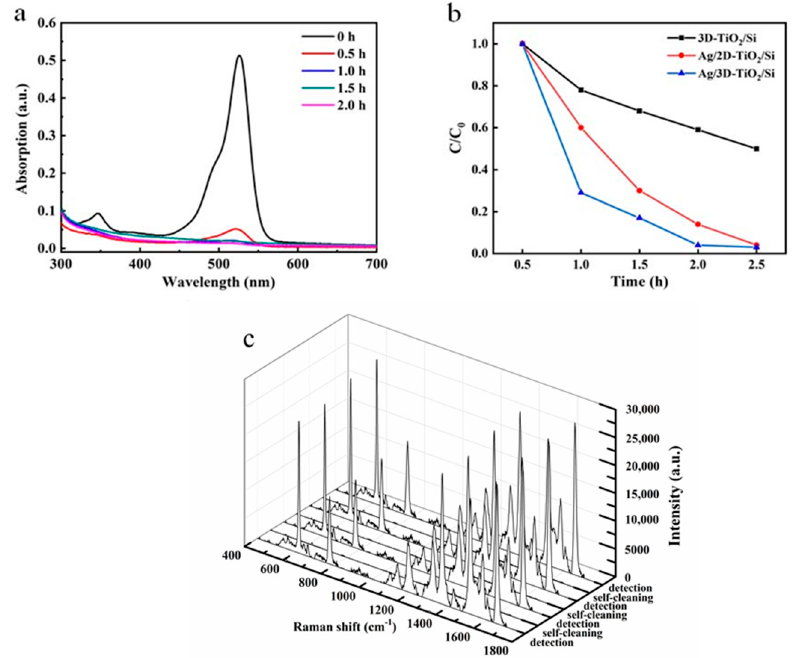
Figure 6. ( a ) UV–vis spectra of R6G under the simulated solar irradiation for different time by Ag/3D-TiO 2 /Si; ( b ) photocatalytic activity of different substrates for the degradation of R6G under the simulated solar irradiation; ( c ) the SERS spectra of Ag/3D-TiO 2 /Si at R6G concentrations of 10 − 4 mol/L and the SERS spectra of the substrate treated with the simulated solar irradiation after adsorption of R6G.